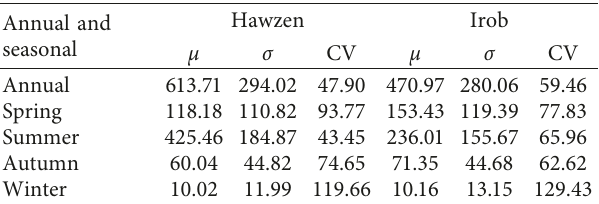
Table 3: Mean ( μ ), standard deviation ( σ ), and CV (%) of rainfall (mm) during 1983–2015.